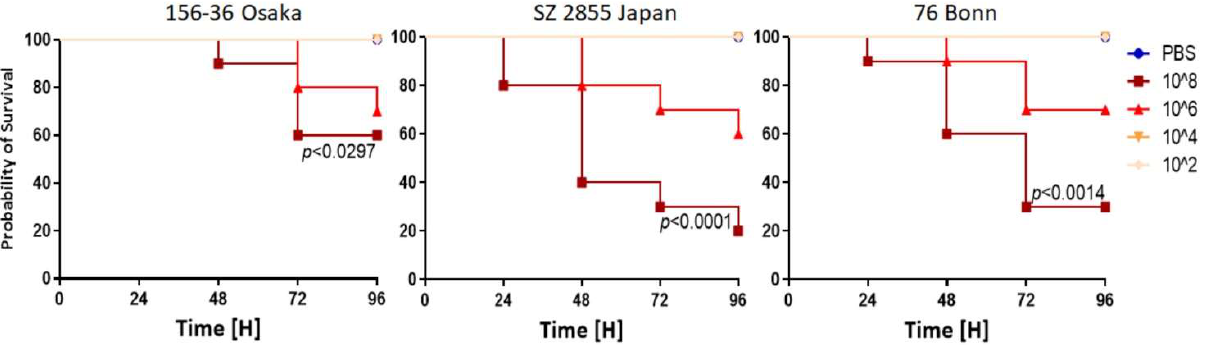
Figure 4. Survival analysis of G. mellonella challenged with S. dysenteriae strains. Larvae ( n = 15) were injected with (10 µL) PBS (blue circle) or S. dysenteriae suspension in PBS in the range of 10 2 to 10 6 c.f.u./per dose. Long rank Mantel-Cox statistic test was used to assess differences between infection groups and the PBS-treated negative control group. At least three independent experiments were conducted, and a representative one is presented on the